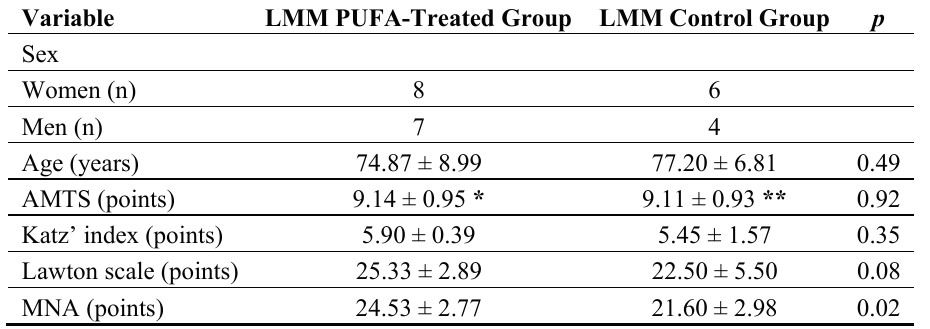
Table 2. The characteristics of studied subjects with low muscle mass (LMM) only.